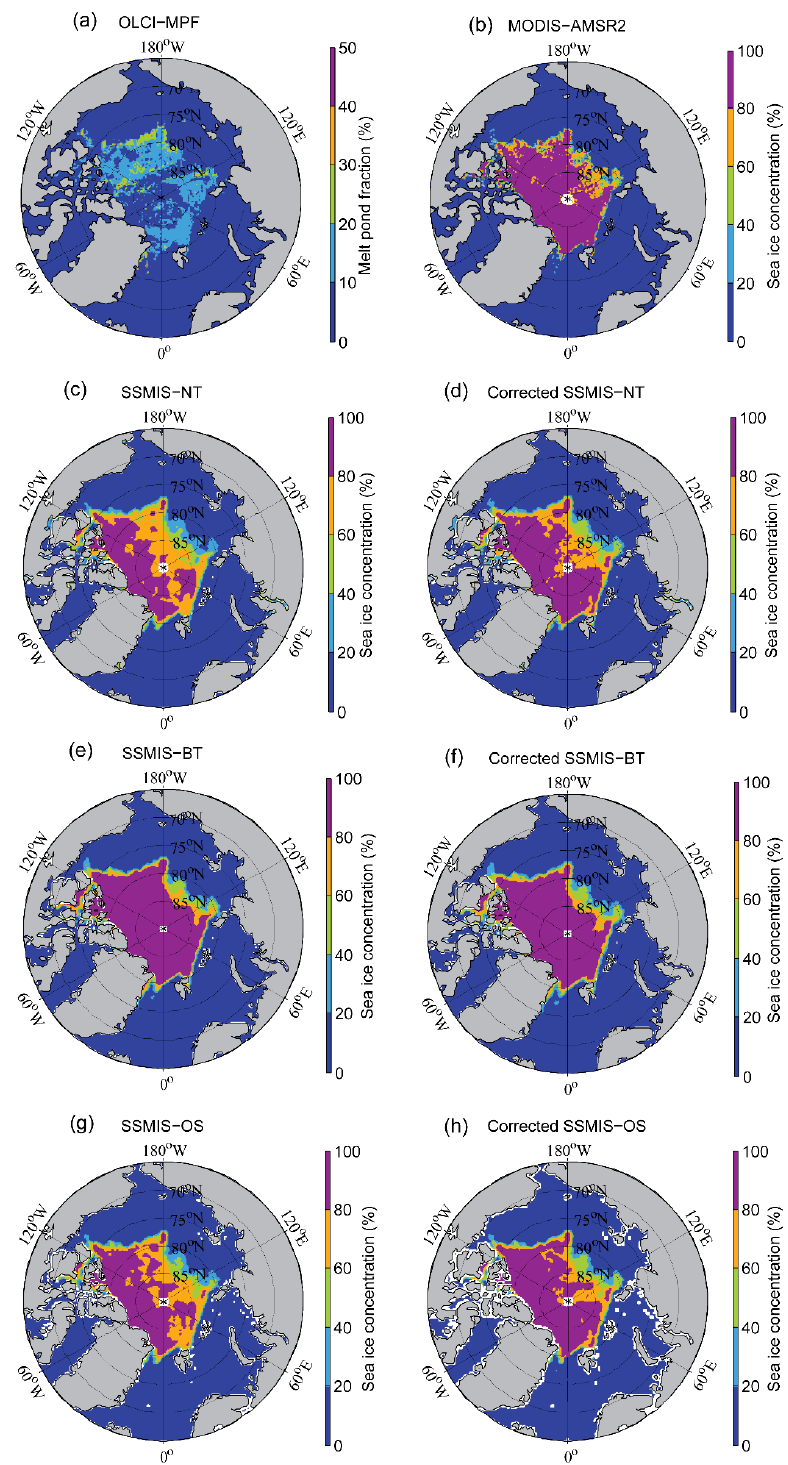
Figure 10. ( a ) The OLCI MPF, ( b ) MODIS-AMSR2 SIC, ( c ) original SSMIS-NT, ( d ) corrected SSMIS-NT SIC, ( e ) original SSMIS-BT, ( f ) corrected SSMIS-BT SIC, ( g ) original SSMIS-OS, and ( h ) corrected SSMIS SIC for 6 September 2019 as an example case.